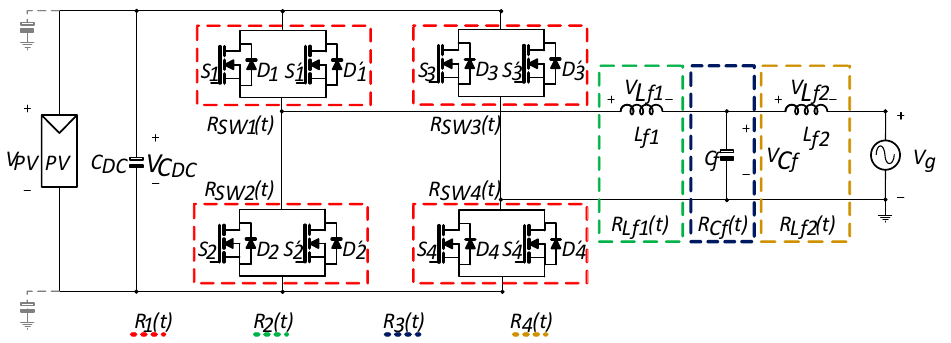
Figure 4. Reliability structures in MOSFET: ( a ) A single MOSFET system in serial; ( b ) Redundant system active in parallel with two MOSFETs; ( c ) Redundant system passive in parallel with two MOSFETs.